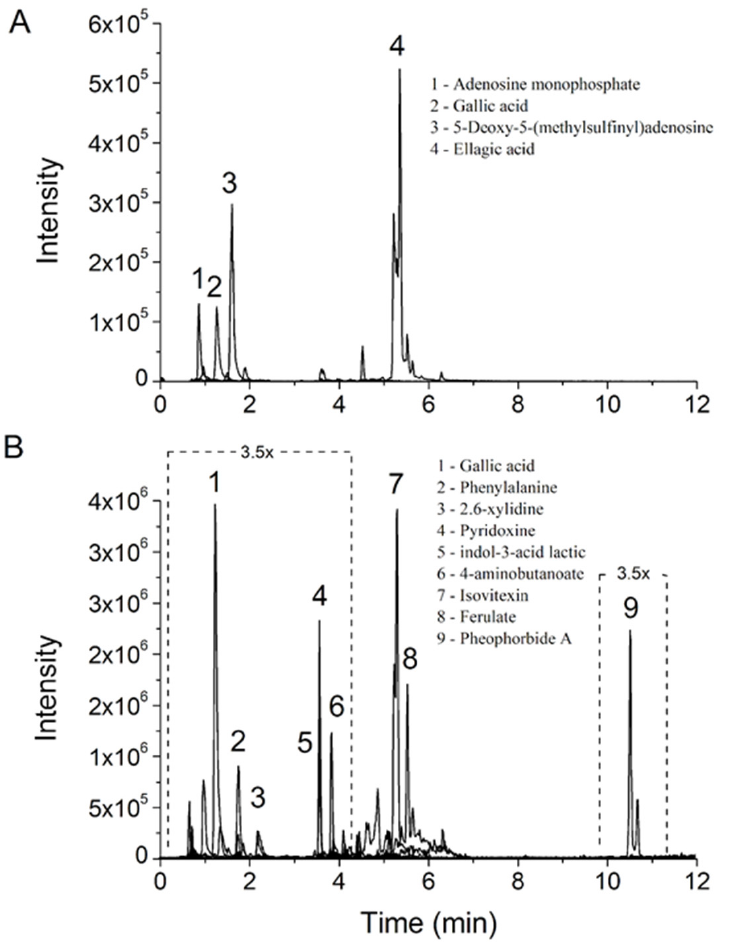
Figure 1. LC–MS/MS fingerprint of L. rigida extracts: ( A ) L. rigida aqueous leaf extract; ( B ) L. rigida hydroethanolic leaf extract. 3.5 x denotes the magnification applied in the dotted areas of the chromatogram. Table 1. Phytocomponents identified in L. rigida leaf extracts by LC–MS/MS analyses. L. rigida aqueous leaf extract (AELR); L. rigida hydroethanolic leaf extract (HELR).